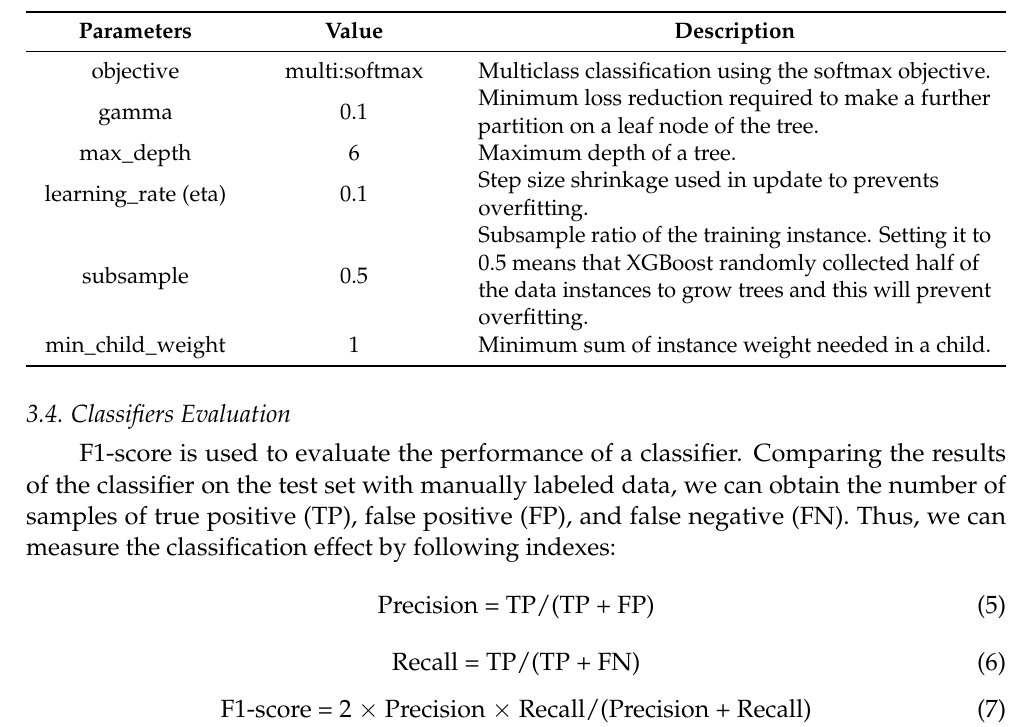
Table 3. XGBoost parameters from xgboost